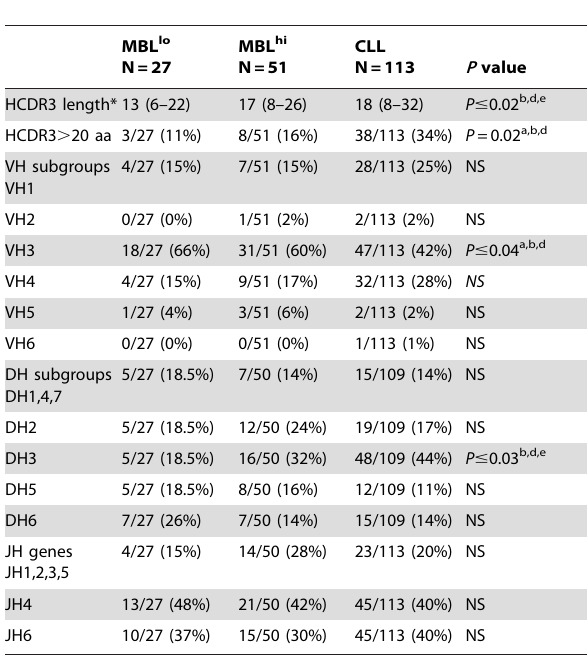
Results expressed as number of B-cell clones from all clones in the corresponding group (percentage) or or as *median (range). Statistically significant differences were found between a MBL hi vs CLL, b MBL lo vs CLL, c MBL lo vs MBL hi , d MBL lo plus MBL hi vs CLL and e MBL lo vs MBL hi plus CLL; NS, no statistically significant differences observed ( P $ 0.05);BCR, B-cell receptor; CLL, chronic lymphocytic leukemia; MBL, monoclonal B-cell lymphocytosis; aa, aminoacids; HCDR3,heavy chain complementarity-determining region 3. cell clones, except for the VH3 and DH3 IGHV genes (Table 4): CLL showed lower frequency of VH3 usage and a greater proportion of DH3 + clones vs MBL lo and MBL hi ( P # 0.04) (Table 4). Of note, a significant percentage of all CLL (72%), MBL hi (74%) and MBL lo (85%) clones corresponded to only 12 IGHV genes, namely V3-23, V3-11, V5-51, V3-21, V1-2, V1-3, V4-39, V3-7, V3-30, V4-34, V3-48 and V1-69 (Figure 1). Among these, preferential usage ( P , 0.04) of the VH3-23 gene was observed in both MBL lo (7/27, 26%) and MBL hi (10/51, 20%) vs CLL (5/113, 4%) clones.